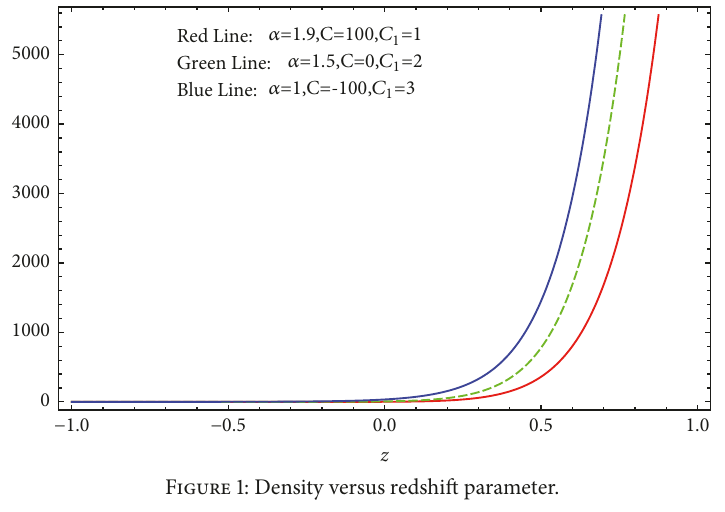
Figure 1: Density versus redshift parameter.